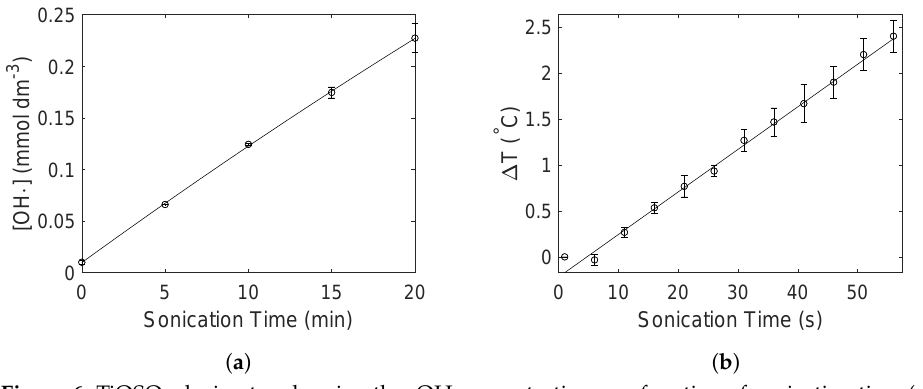
Figure 6. TiOSO 4 dosimetry showing the · OH concentration as a function of sonication time ( a ). The concentration of the · OH was estimated from the hydrogen peroxide concentration. Calorimetry measurements of the acoustic power of ultrasound showing the resulting temperature increase in water as a function of sonication time ( b